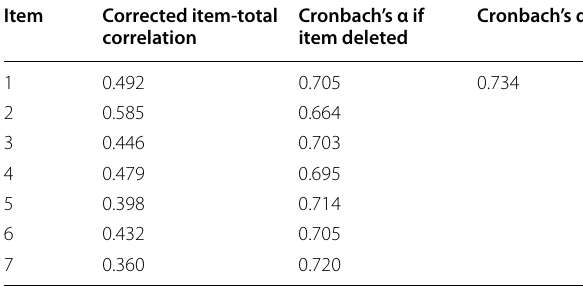
Table 4 Comparison of the Malay version of sqOD-NS scores between smell dysfunction patients and healthy control